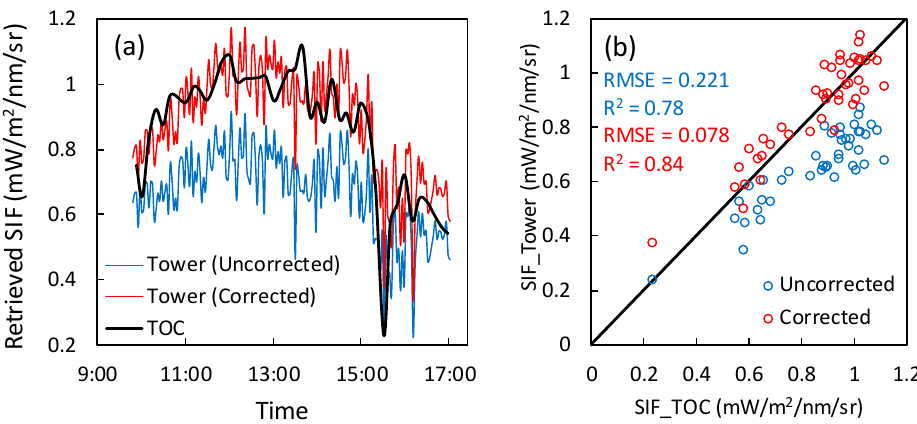
Figure 7. Results of SIF retrieval from synchronous tower-based and ground-based spectral observations of summer maize at the filling stage (measured on September 7, 2018, at the Daman site). ( a ) Diurnal variation of SIF retrieved from tower-based observations before/after atmospheric correction, and from synchronous ground-based observations. ( b ) Relationship between the SIF values retrieved from synchronous ground-based observations and tower-based observations with and without atmospheric correction.